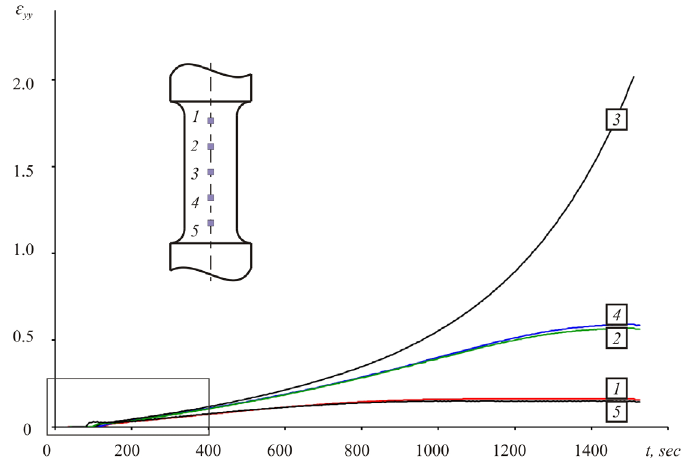
Figure 6: Time dependences of axial strain for five areas of material.